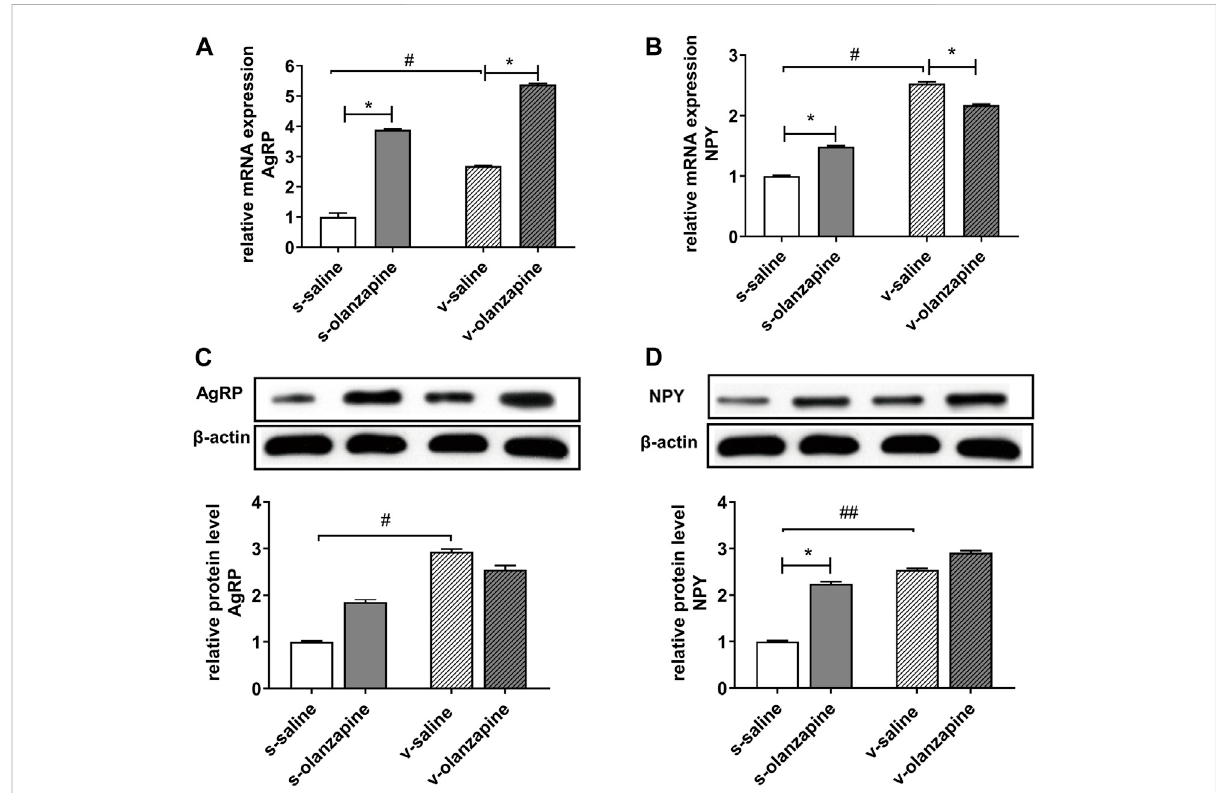
FIGURE 6 DifferentexpressionsinmRNA (A,B) andprotein (C,D)